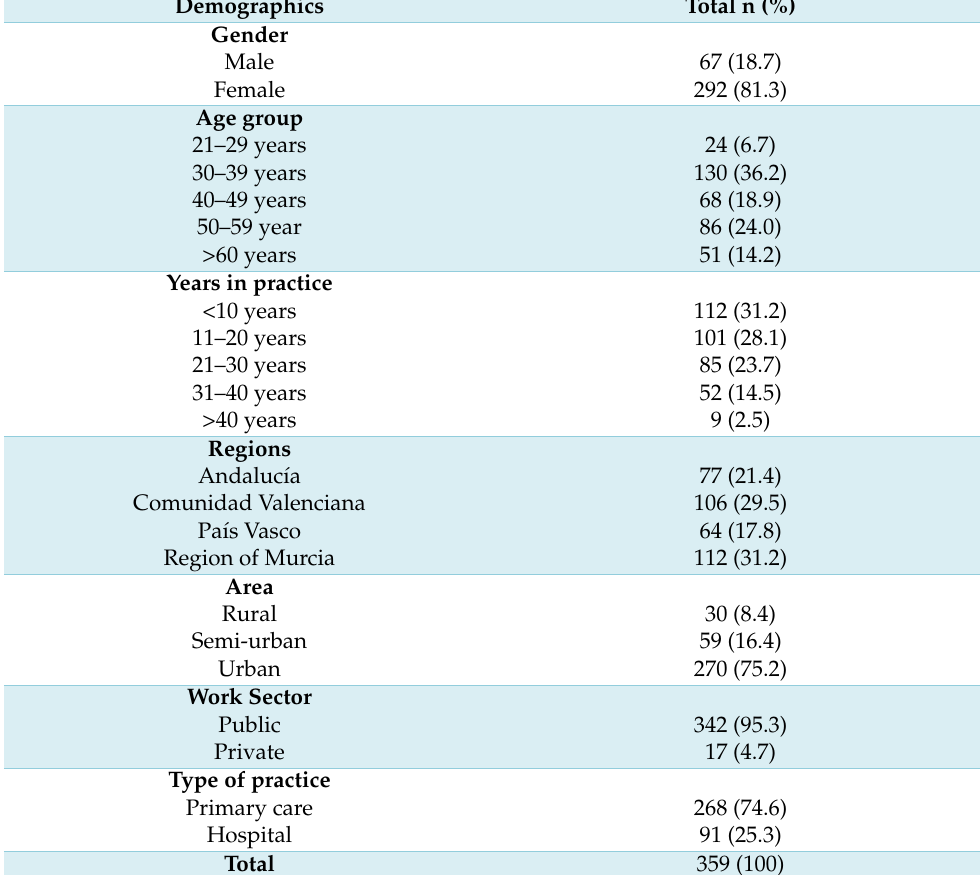
Table 1. Demographic characteristics of participants.